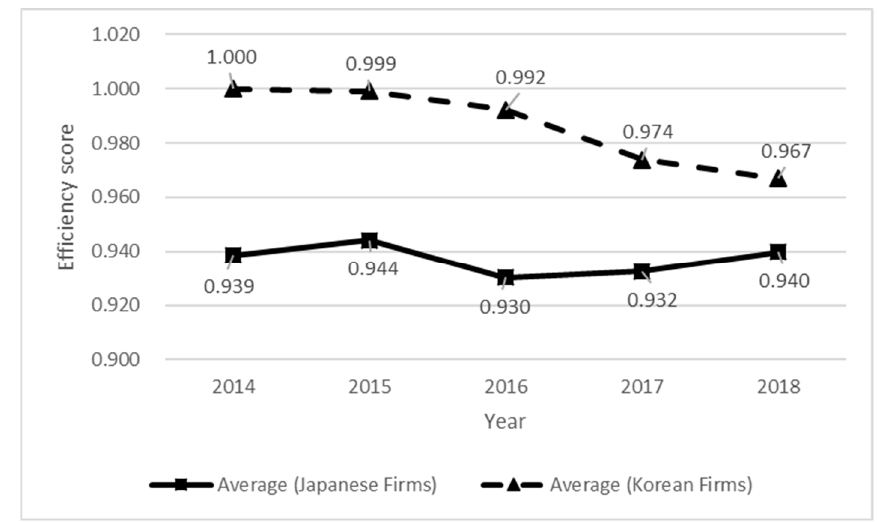
Figure 4. Average Efficiencies of Japanese and Korean Power Companies: Multiplier Restriction. Note: See Figure 4. Average E ffi ciencies of Japanese and Korean Power Companies: Multiplier Restriction. Note: the bottom of Figure 3. See the bottom of Figure